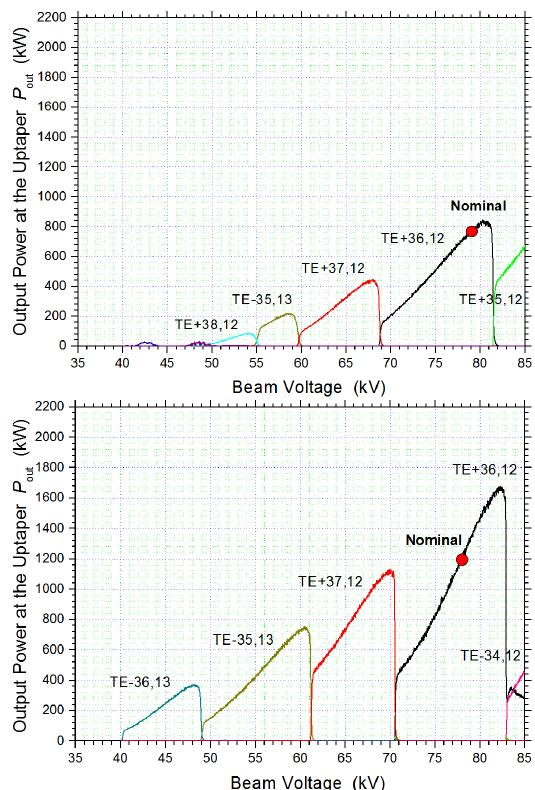
Fig. 3. Multi-mode simulation (46 competing modes) of the diode start-up for gyrotron operation at 175 GHz, assuming α = 0.8 (top) and α = 1.1 (bottom). A negative azimuthal index denotes a counter-rotating